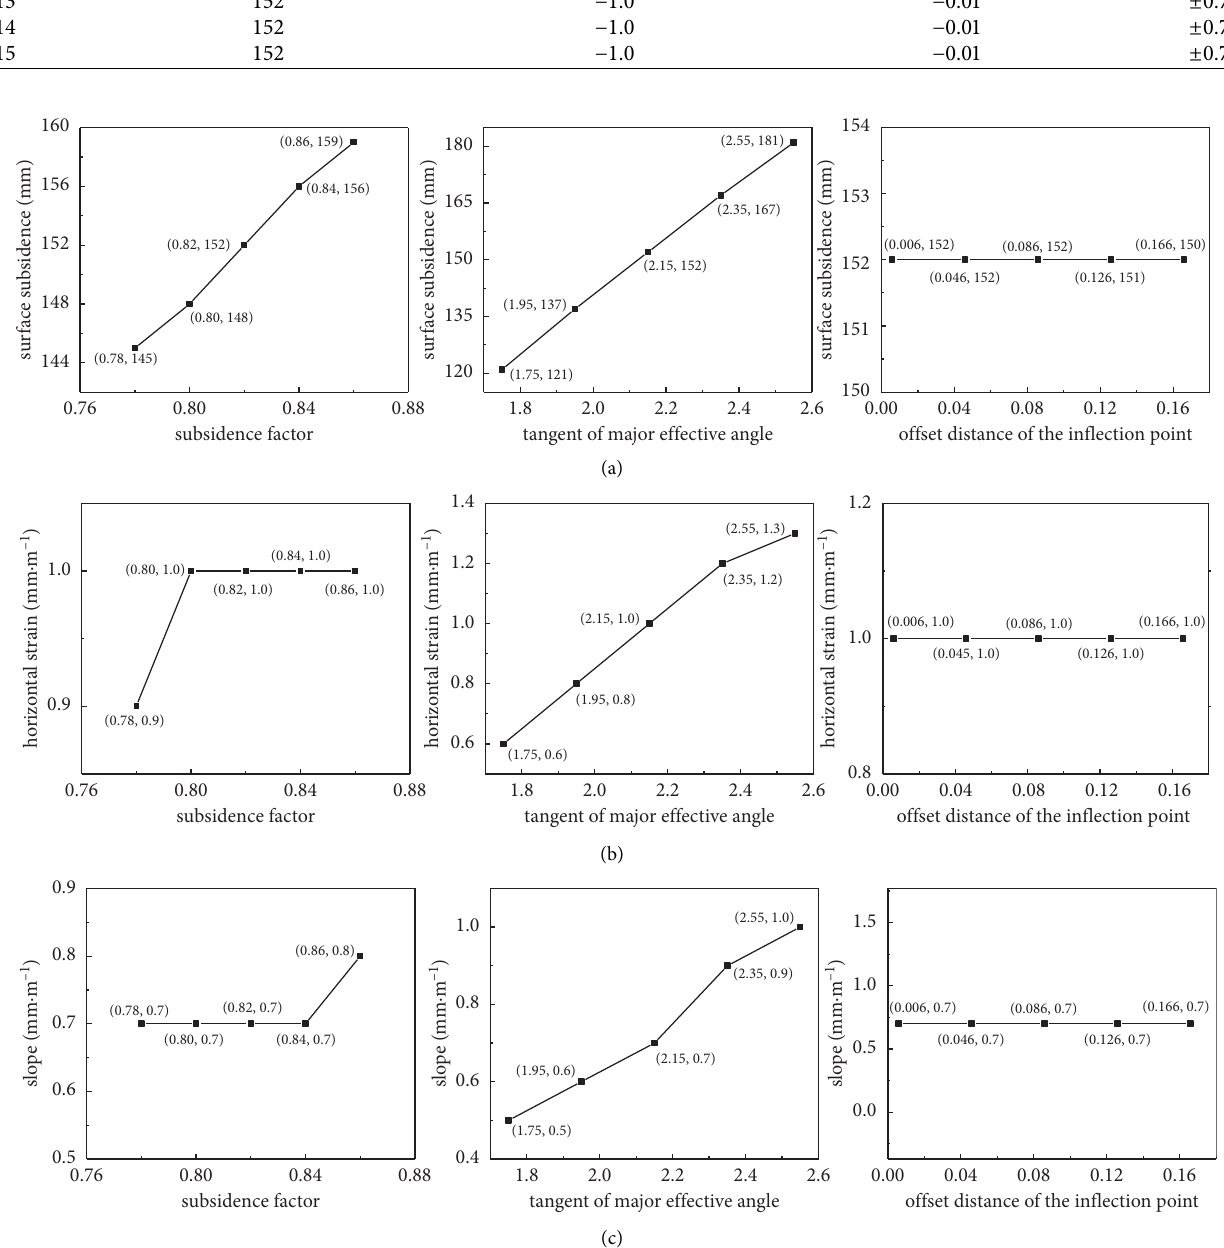
Figure 11: Predicted results: (a) surface subsidence values, (b) horizontal deformation, and (c)